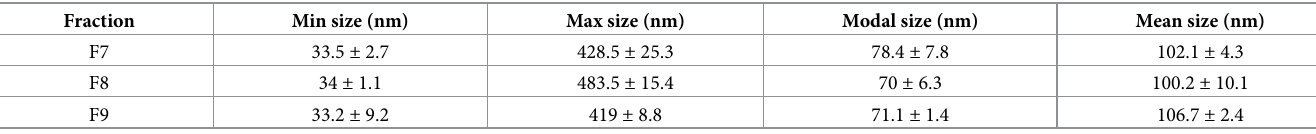
Table 1. Size of FDNVs in fractions 7, 8 and 9 using nanoparticle tracking analysis (n = 3).